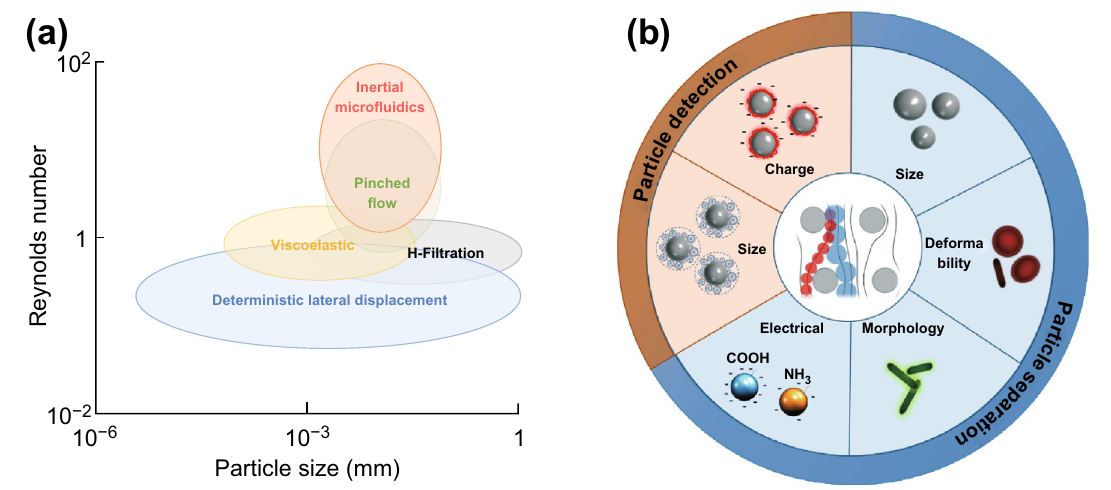
Fig. 1 a Overview of the working range of passive microfluidics techniques. DLD mostly operates at a low Reynolds number and has high dynamic size separation range compared to other passive techniques. b A summary of DLD applications for particle separation and